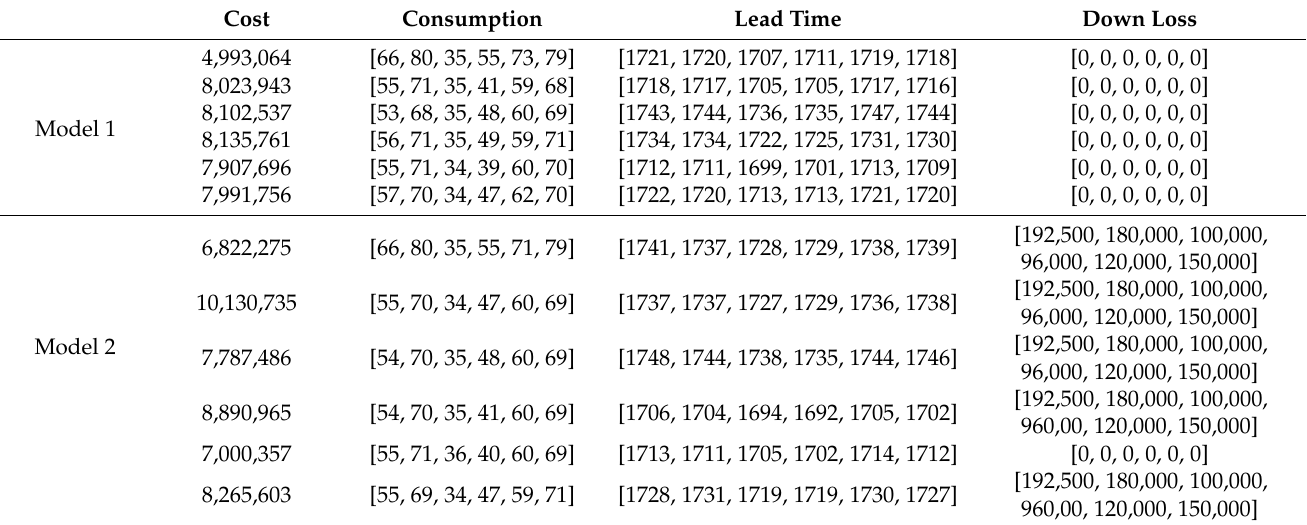
Table 4. Results of two inventory